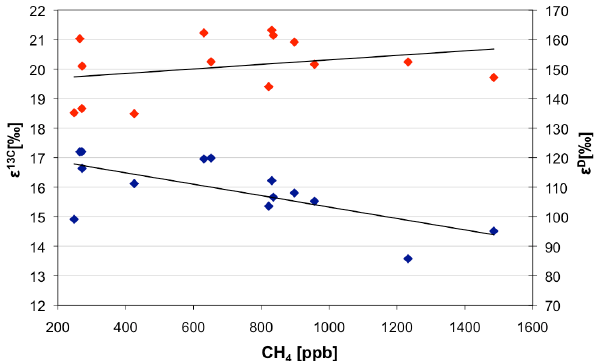
Figure 10: Dependence of mean fractionation factors of each flight ( ε 13C in blue ♦ , ε D in red ■ ) on the corresponding lowest mixing ratio c min observed. Fractionation factors are taken from Table 5 and include the correction for the tropospheric temporal trends.